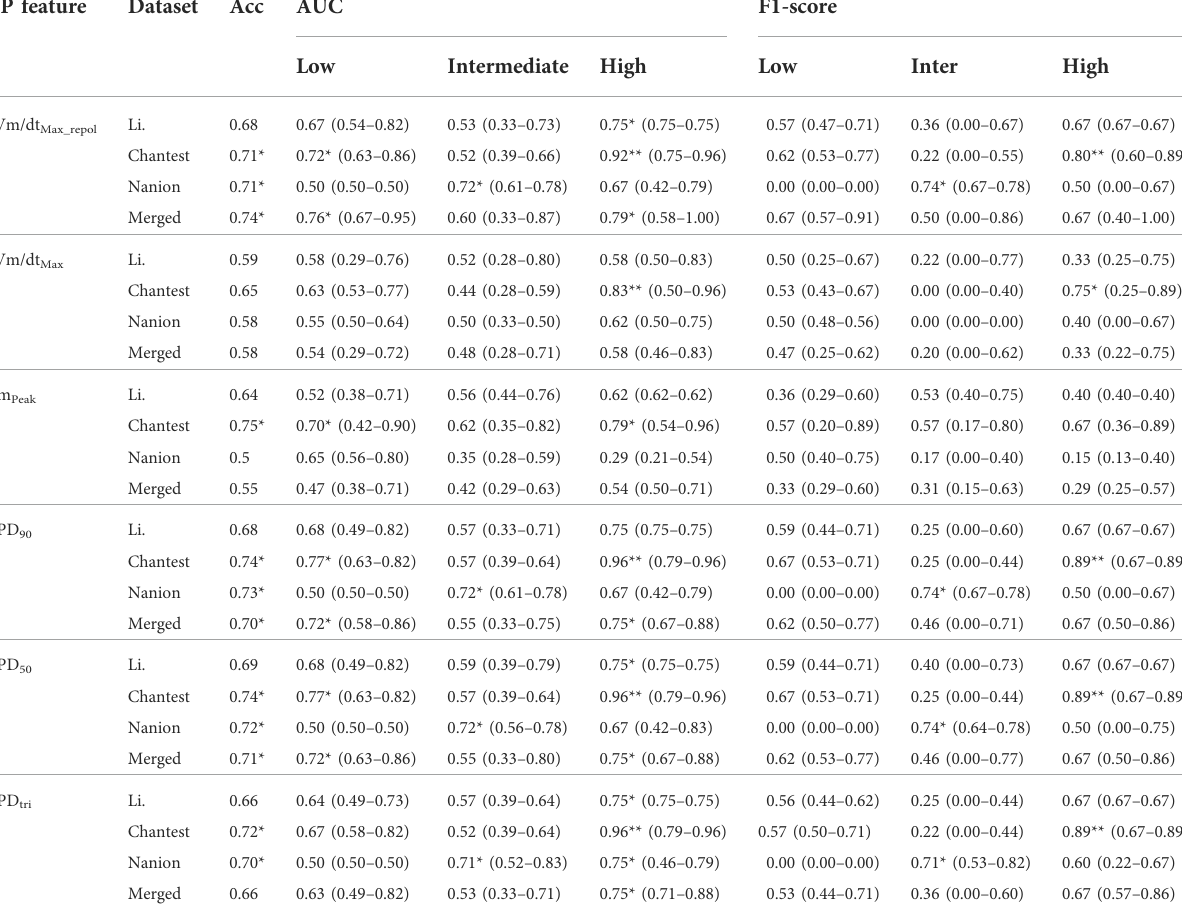
TABLE 3 Summaryof classi fi cation performance using action potential(AP) features; classi fi cation performancesaccording to theAP features shows the median, minimal and maximal values after evaluating the model through the 10,000-test algorithm; AUC, the area under the receiver operating curves; Merged, the combined set containing all three datasets; ACC, accuracy; One asterisk (*) denotes the intermediate performance over 0.7 of median values, and two asterisks (**) denote the excellent performance over 0.8 of median